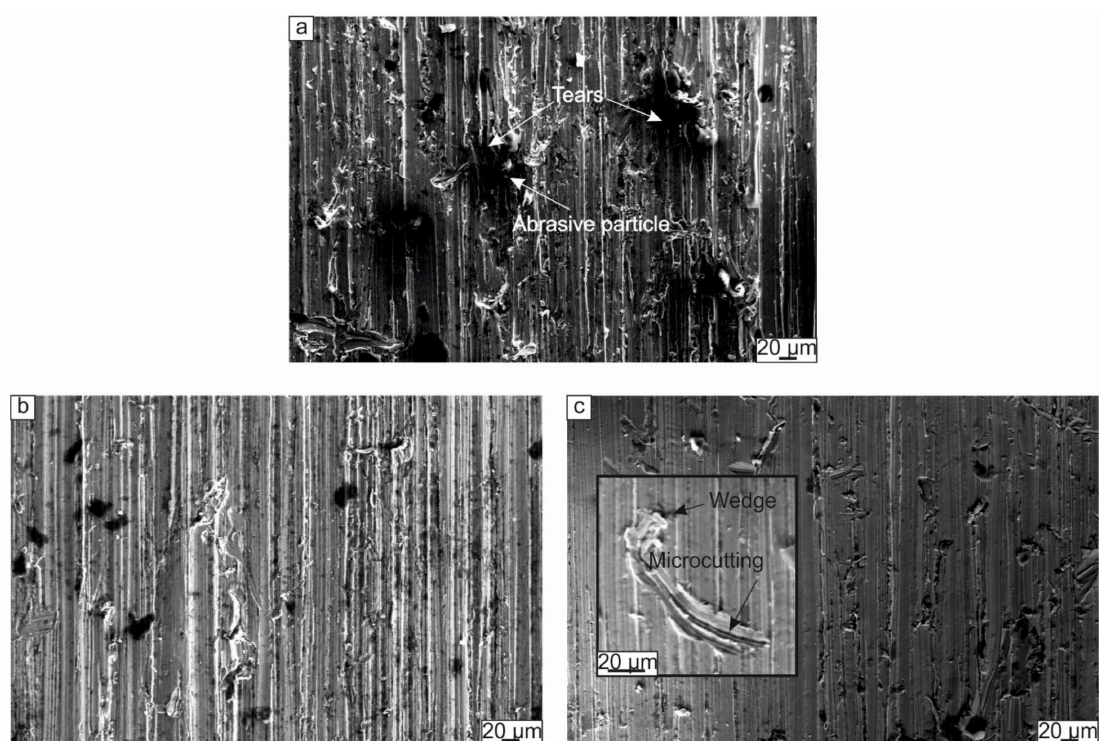
Figure 7. SEM images of the worn surfaces of pure titanium ( a ), Ti-41Al-7Cr cladding layer ( b ), Ti-41Al-7Ta cladding layer ( c ) after a friction test against fixed abrasive particles. SEM micrographs were obtained in the secondary electron